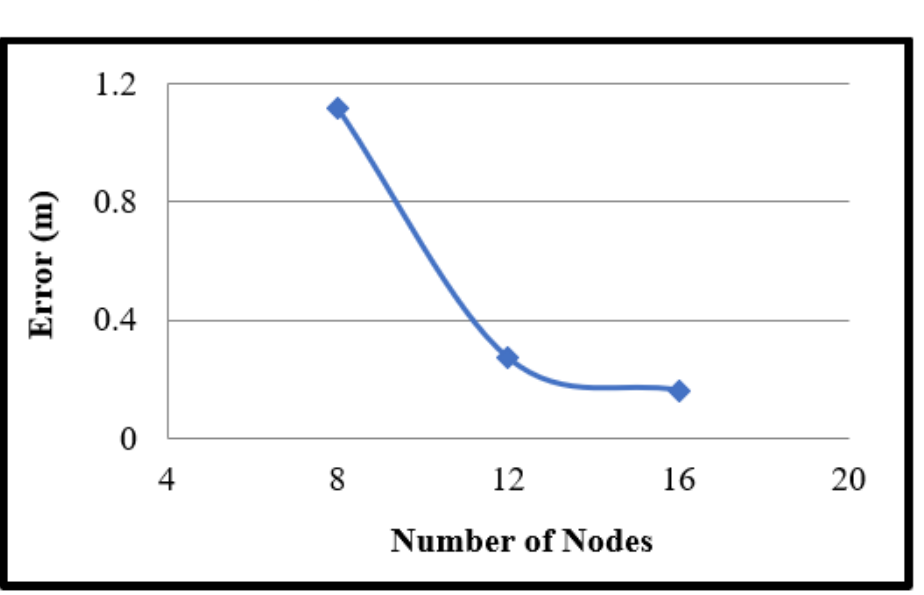
Figure 2. As the number of nodes increases, the error decreases in the same area size.